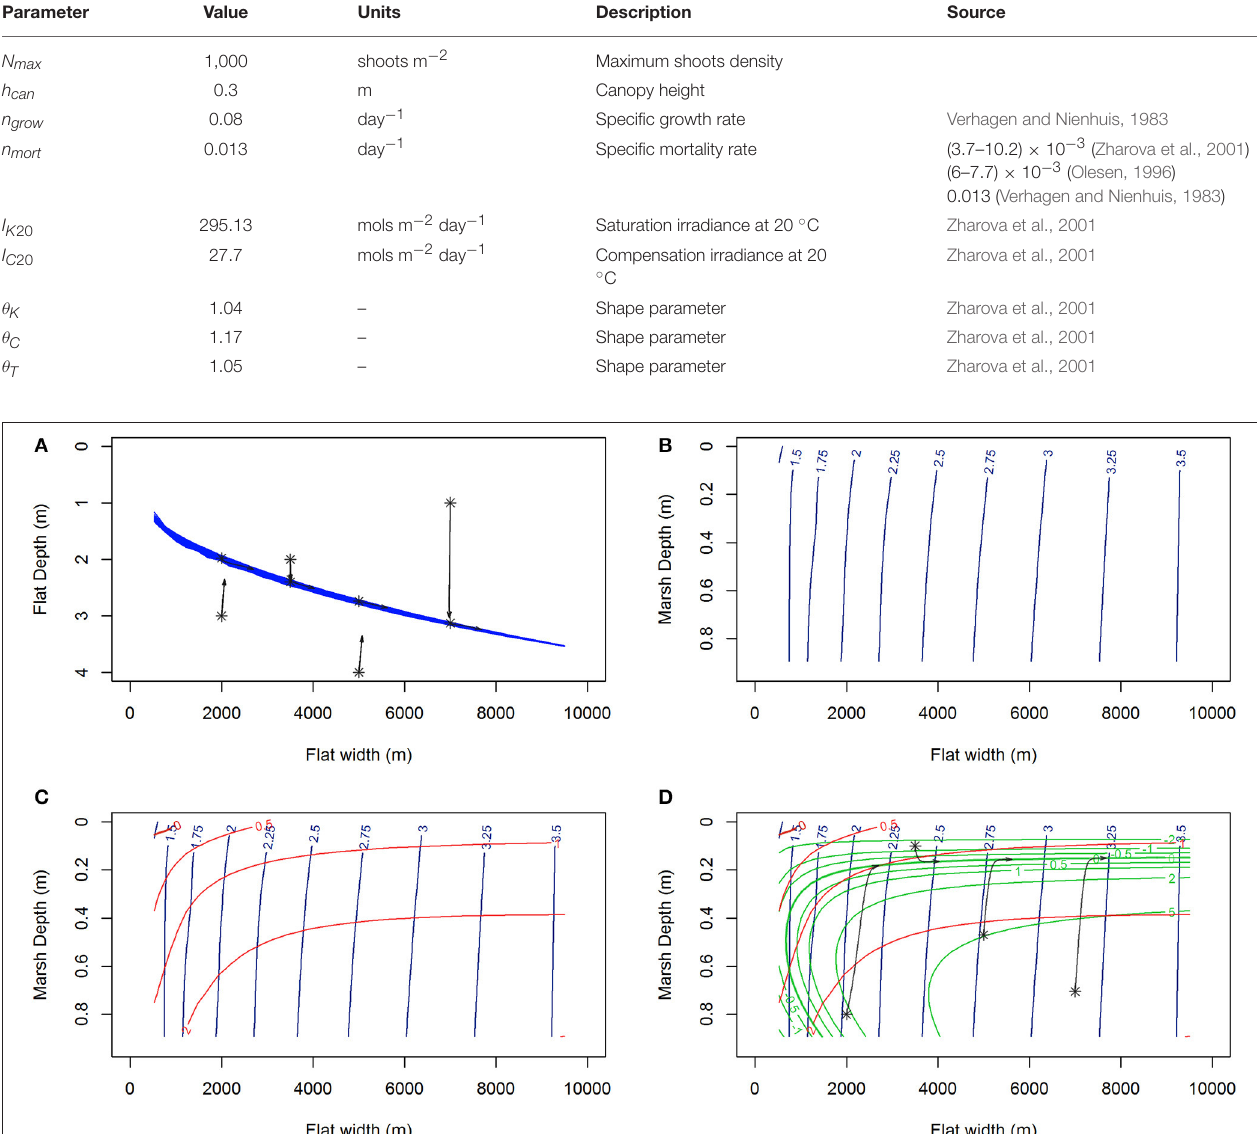
TABLE 1 | Seagrass model parameters and sources.